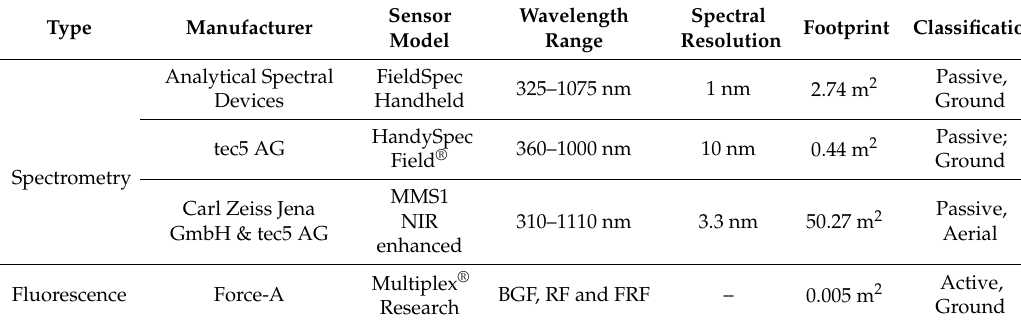
Table 3. Used sensor devices and sensor details. BGF = Blue-Green Fluorescence; RF = Red Fluorescence; FRF = Far-Red